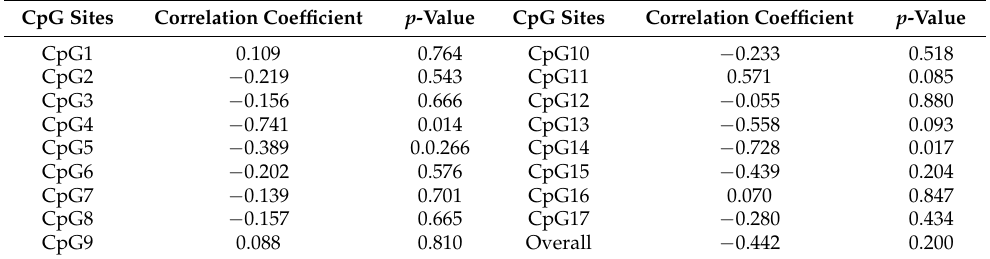
Table 7. Correlation coefficient of CpG III methylation rate and KRT17 expression.